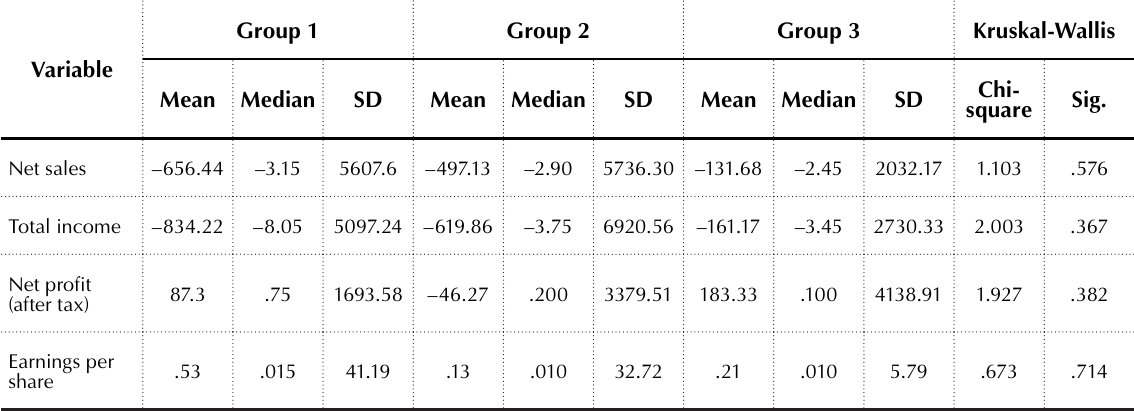
Table 6. Kruskal-Wallis